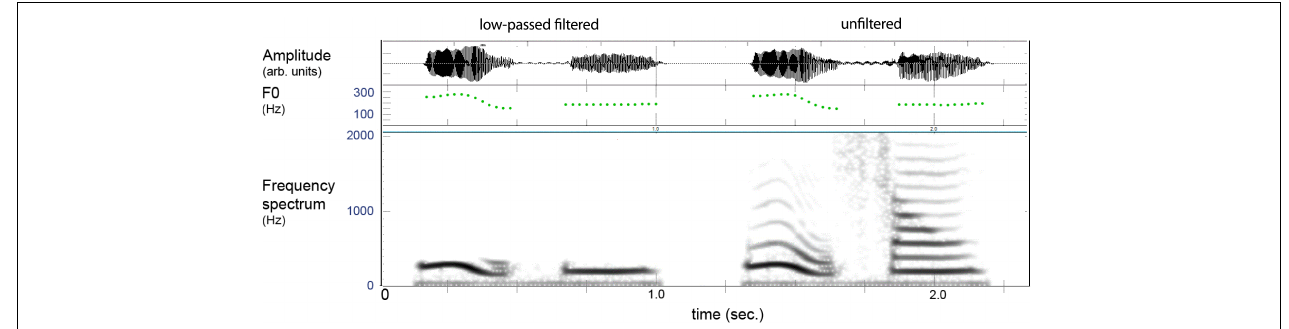
FIGURE 3 | Example of filtered (left) and unfiltered (right) versions of a two-syllable lexeme in Mandarin. The filtering leaves the pitch (F0) of the lower harmonic, and the item is heard as vocalized tones without “vowel” or “consonant” features.